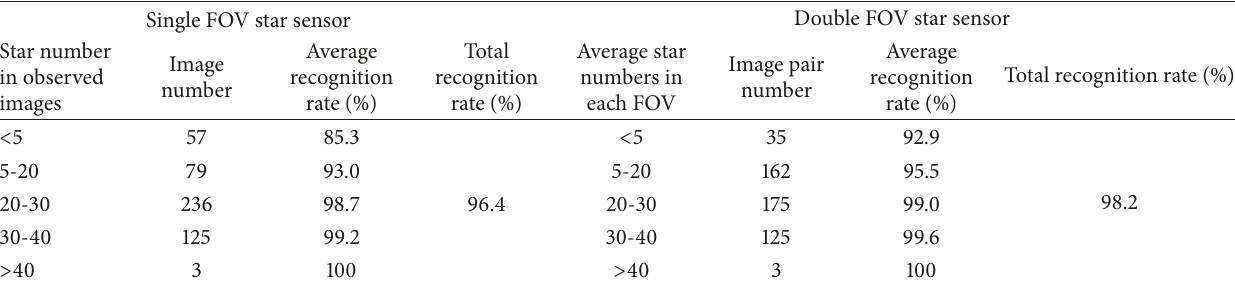
Table 2: Comparison between single/double FOV star